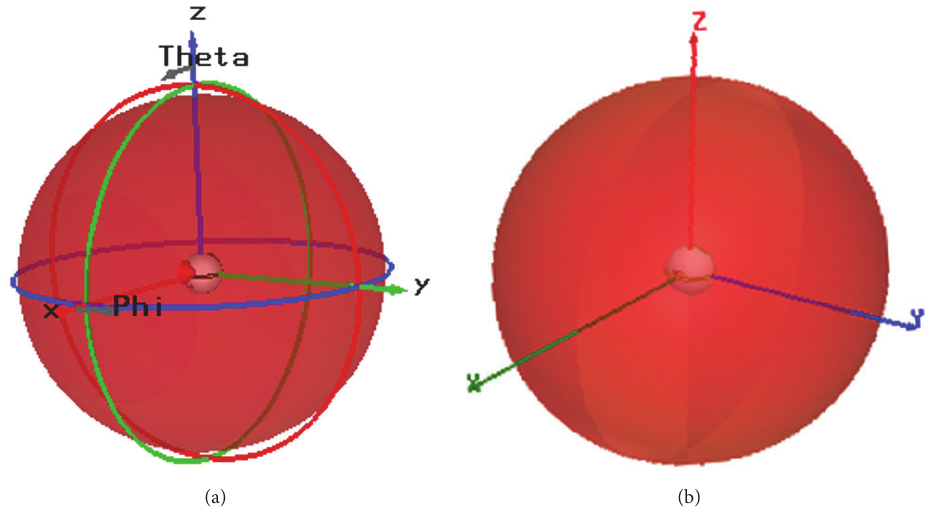
Figure 28: Radiation patterns ( 𝐸 total ) in 3D of the 3D spherical antenna (Table 10): (a) CSE and (b)